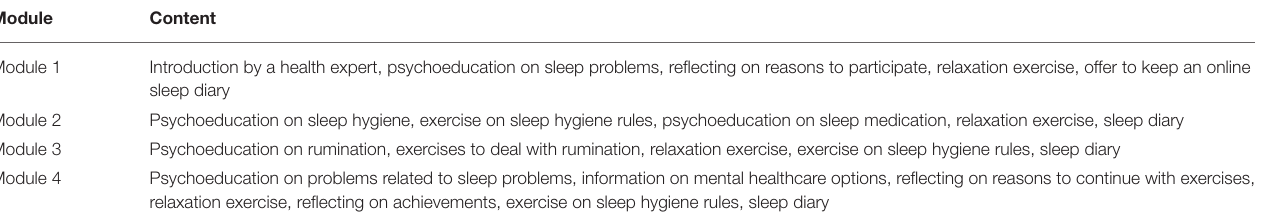
TABLE 1 | Contents of the four modules of the culturally adapted digital sleep intervention eSano Sleep-e.